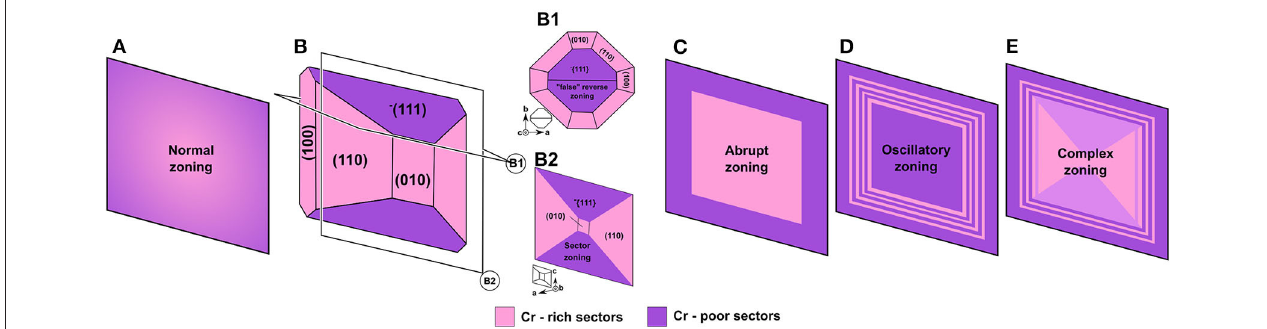
FIGURE 1 | Types of zonation visible in pyroxene. A schematic illustration using Cr content in clinopyroxene to illustrate the zoning types. Normal zoning (A) is common in unmineralized/barren intrusions and is characterized by a diffuse reduction in chromium (and other compatible elements) concentration toward the rims. (B) Sector zoning, hourglass style zonation in Cr concentration in the core of the pyroxene, Modified from Welsch et al. (2016). Cross sections through the b and c axis give; (B2) hourglass sector-zoned clinopyroxene and (B3) a false-reverse zoned clinopyroxene. (C) Abrupt zoning: a rapid change in the trace element chemistry between the core and rim (D) oscillatory zoning: repetitive cycles of chemistry change within the crystal. (E) Complexly zoned pyroxene can be made up of a combination of (B–D)